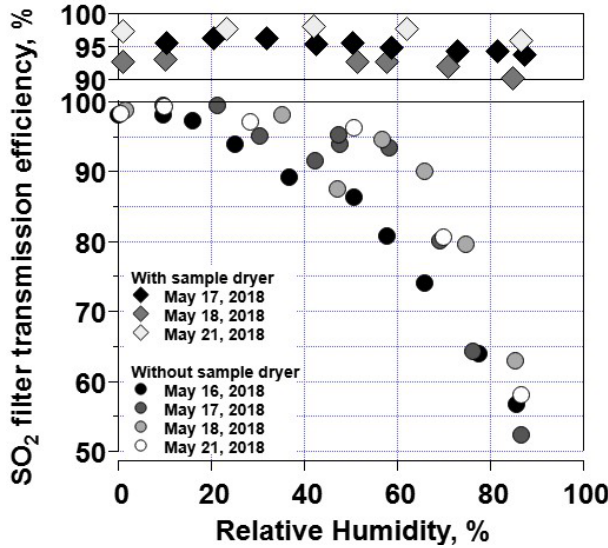
Figure 6. Tests of SO 2 transmission efficiency as a function of rel- ative humidity without (circles) and with (diamonds) an upstream sample dryer.